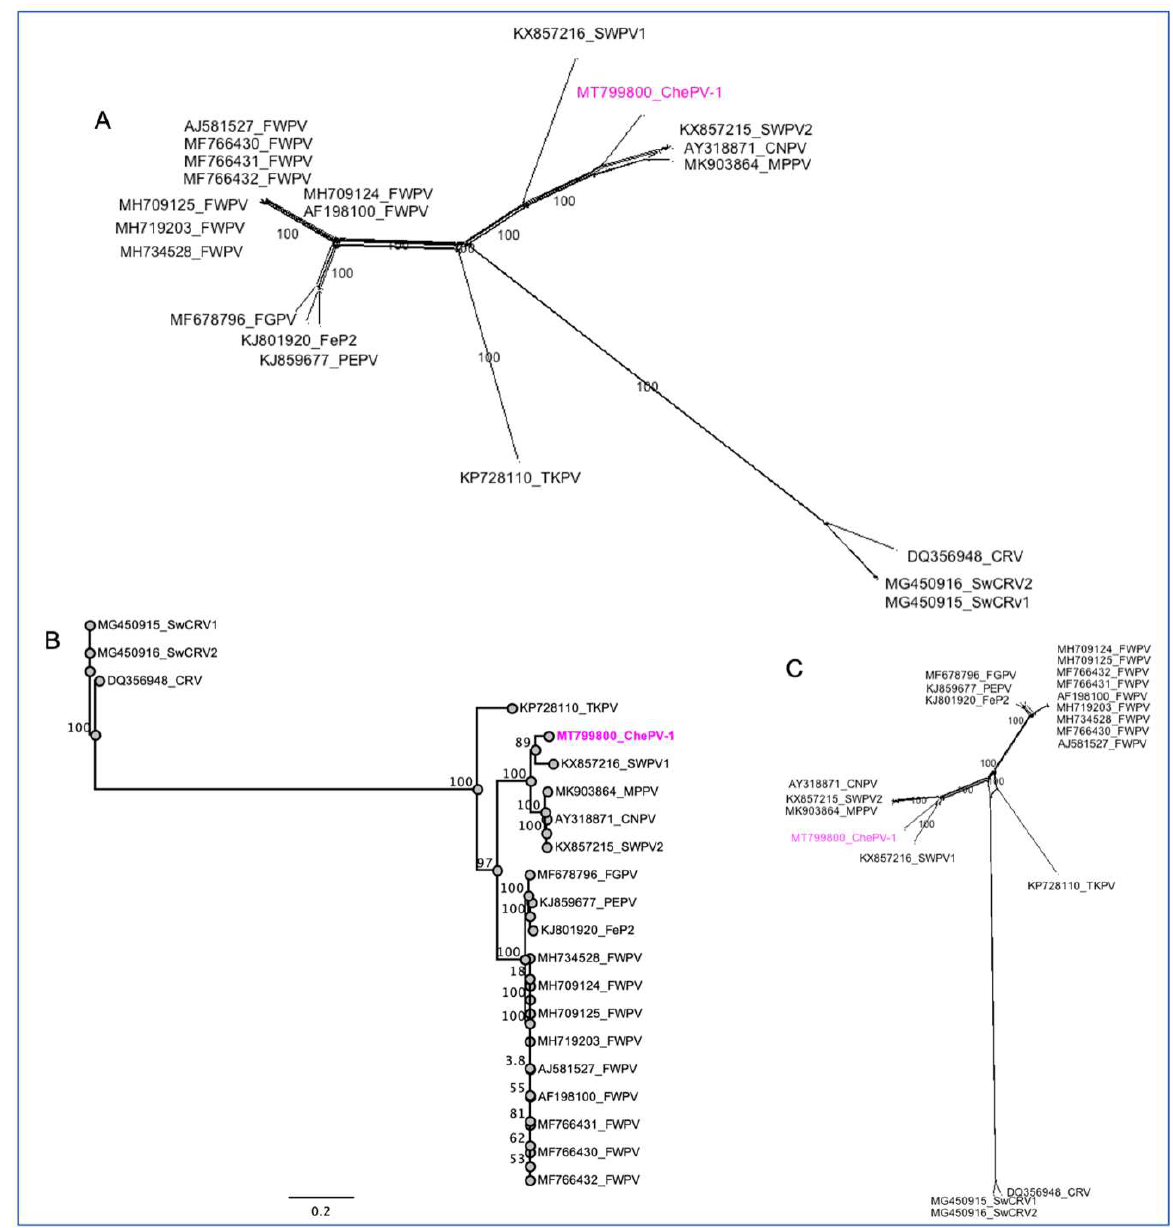
Figure 4. Phylogenetic relationship between novel cheloniid poxvirus 1 (ChePV-1) and other chordopoxviruses. ( A ) Boot- strap Network based on the complete genome sequences of the selected ChPVs. ( B ) Maximum likelihood (ML) tree and ( C ) Bootstrap Network based on the concatenated amino acid sequences. The numbers on the left show bootstrap values as percentages, and the ChePV-1 is highlighted with magenta color. The labels at branch tips refer to original ChPVs GenBank accession number followed by abbreviated species name.